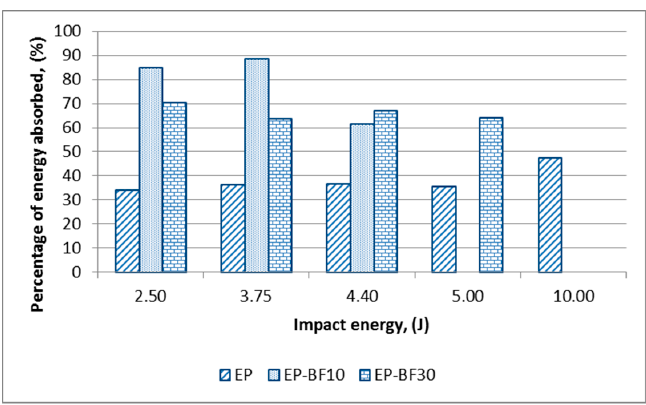
Figure 5. Percentage of energy absorbed by the EP and EP-BF composites at the first range of impact energy levels.